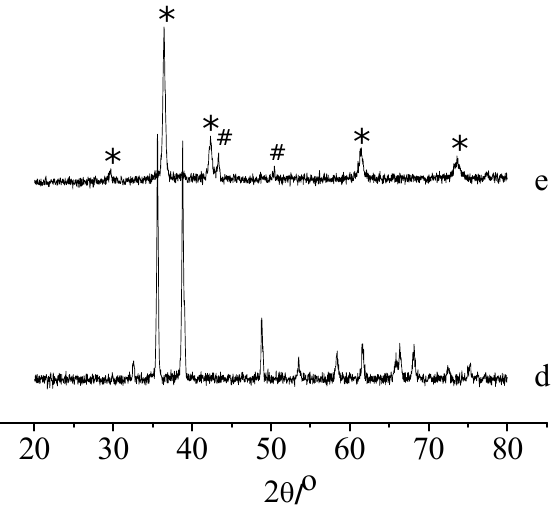
Figure 8. XRD spectra of CuO: d) newly prepared; e) used 3 times; peaks with * are from Cu O, # are from Cu. 2